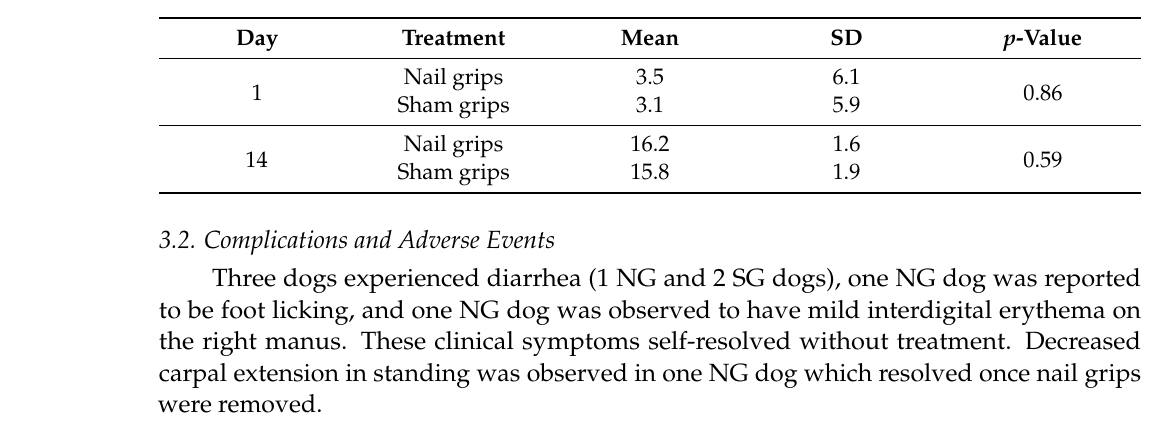
Table 4. Mean ± SD total pressure index (TPI) for the nail grips group as compared to the sham